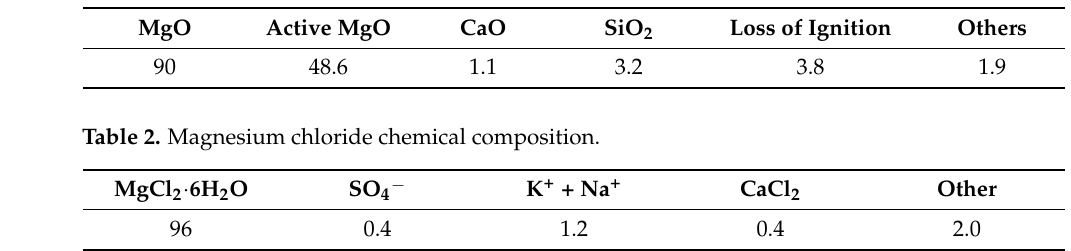
Table 1. Magnesium oxide chemical composition.